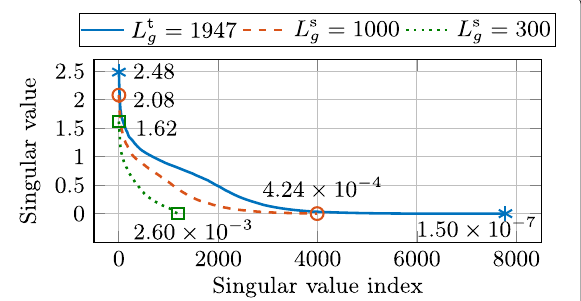
Fig. 3 Singular values of the matrix W t ˆ H t ( L t g = 1947) and of two (cid:21) (cid:22) L s g = 1000 and L s g = 300 sub-matrices W s ˆ H s for PMINT. The largest and the smallest non-zero singular values of each matrix are explicitly marked. The considered acoustic system is system S 1 described in Section